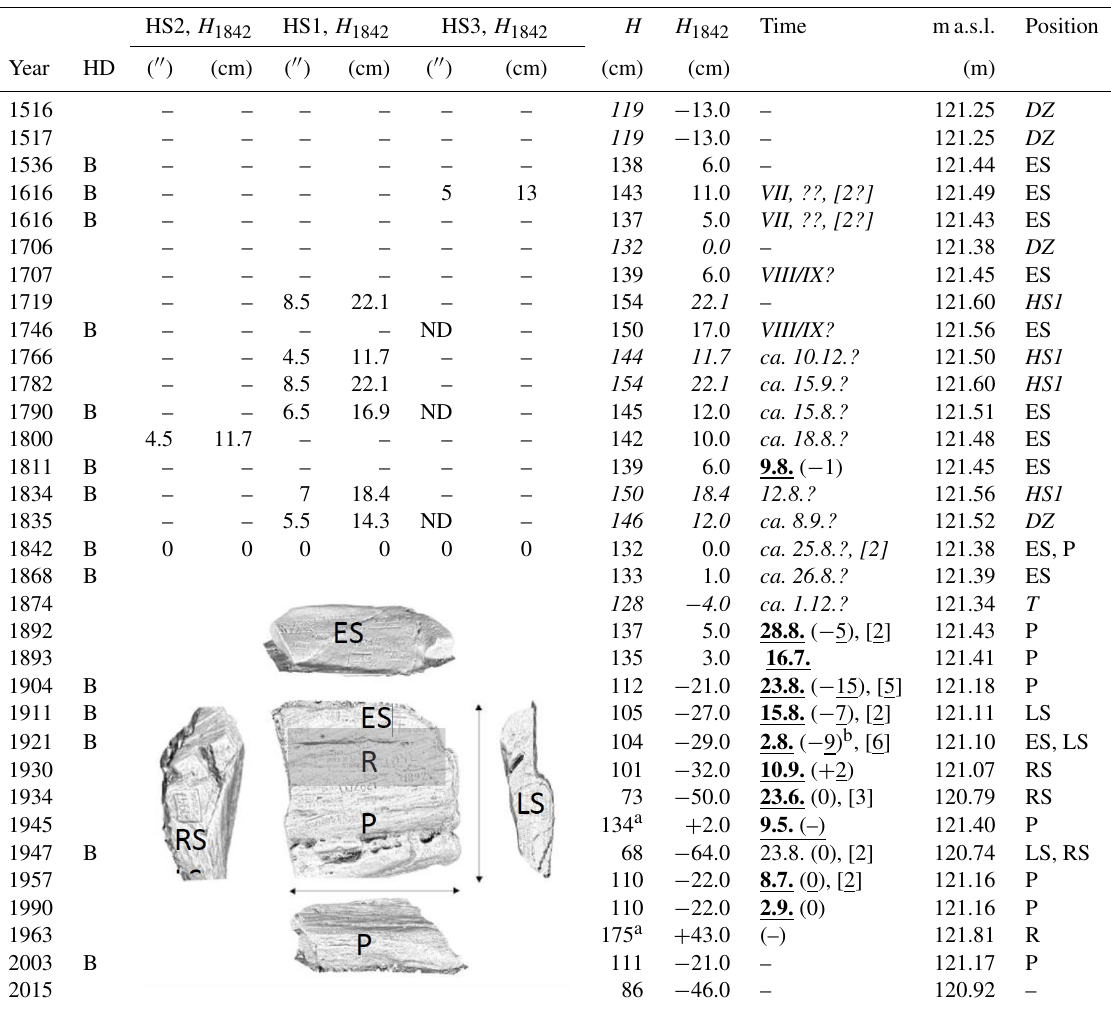
Table 4. Overview of the annual water level minima on the hunger stones in